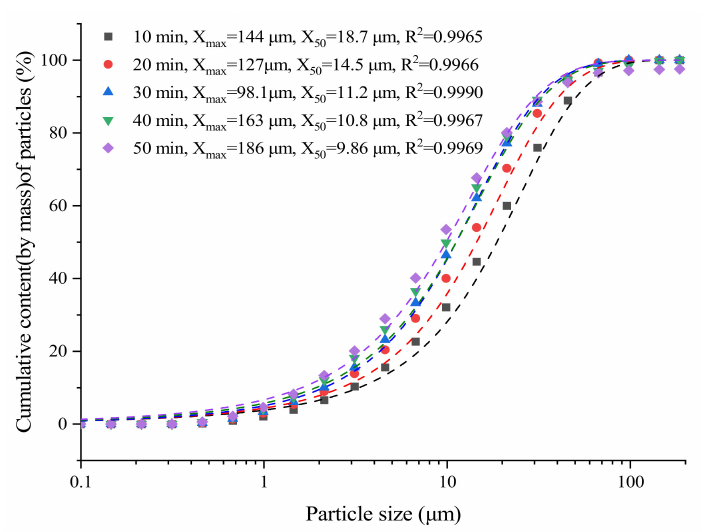
Figure 9. Swebrec function fitting of LVTC powder ground for different times. Table 6. Parameters and R 2 -Adj of the RRB and Swebrec function models.